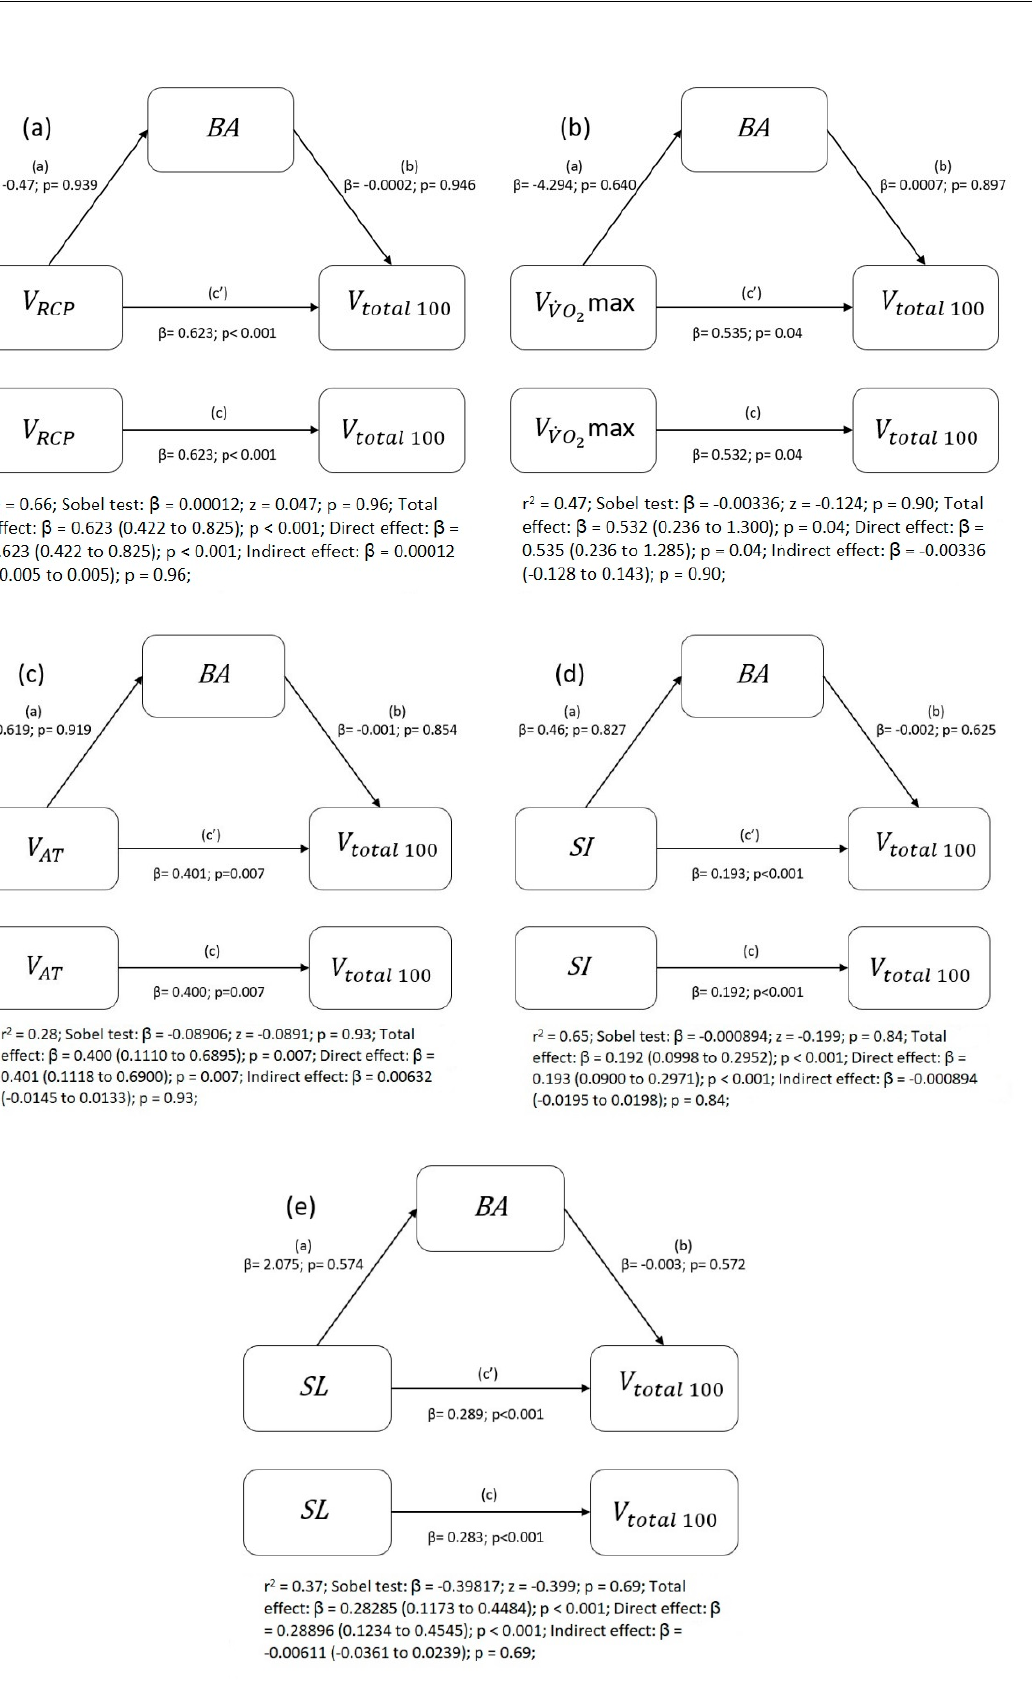
Figure 3. Mediation models illustrating the level of mediation effects of the relation between the independent variables of: ( a ) V RCP , ( b ) V . , ( c ) V AT , ( d ) SI , ( e ) SL and dependent variable of V total 100 . β and corresponding p -values are presented. β of total (c), direct (c’), and indirect ( a , b ) effects are presented with 95% confidence intervals, p -value.